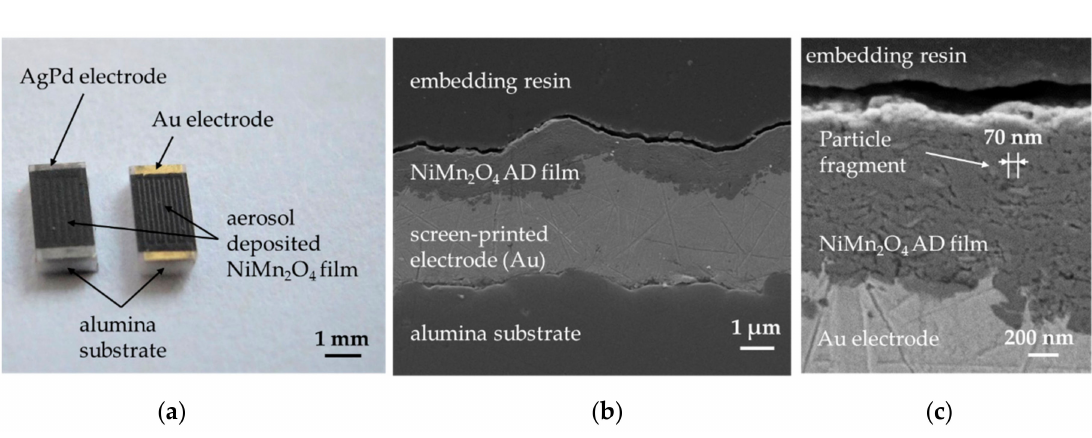
Figure 2. ( a ) Aerosol deposited NiMn 2 O 4 film on alumina substrates with screen printed AgPd electrodes (left) and Au electrodes (right); ( b ) Cross section of a NTCR component in SEM, consisting of a NiMn 2 O 4 AD film on screen-printed Au electrodes on alumina substrate; ( c ) Detailed view of ( b